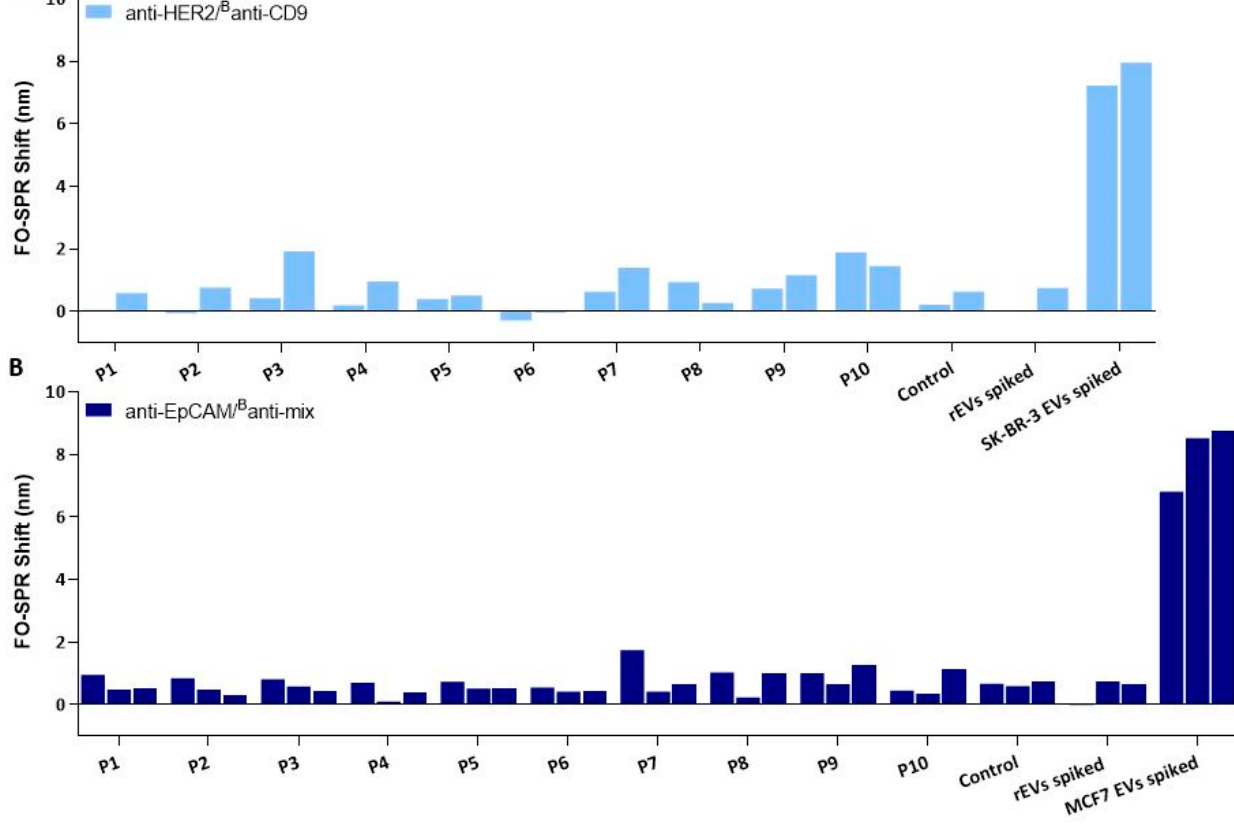
Figure 5. Specificity testing of the FO-SPR bioassays in 100-fold diluted plasma using ( A ) anti- HER2/ B anti-CD9 and ( B ) anti-EpCAM/ B anti-mix antibody combinations. P1 to 10 are plasma samples of 10 individual healthy donors unknown to be diagnosed with breast cancer. Control is 100-fold diluted pooled plasma. Two additional controls represent (1) rEVs spiked in 100-fold diluted pooled plasma and (2) SK-BR-3 (in panel ( A ) or MCF7 EVs (in panel ( B ) spiked in 100-fold diluted pooled plasma. For panel ( A ), two independent measurements were performed for all the samples, whereas the number of repetitions was three for panel ( B ) (although some of the obtained values are close to zero and thus barely visible).